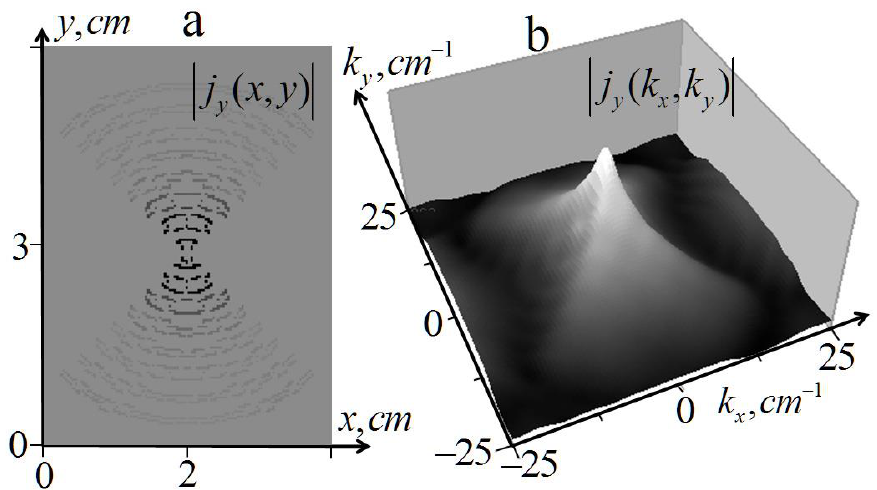
Figure A1. ( a ), Distribution of the y -component amplitude of currents on the bow-tie antenna at frequency f = 1.5 GHz; ( b ), corresponding k -space spectrum.